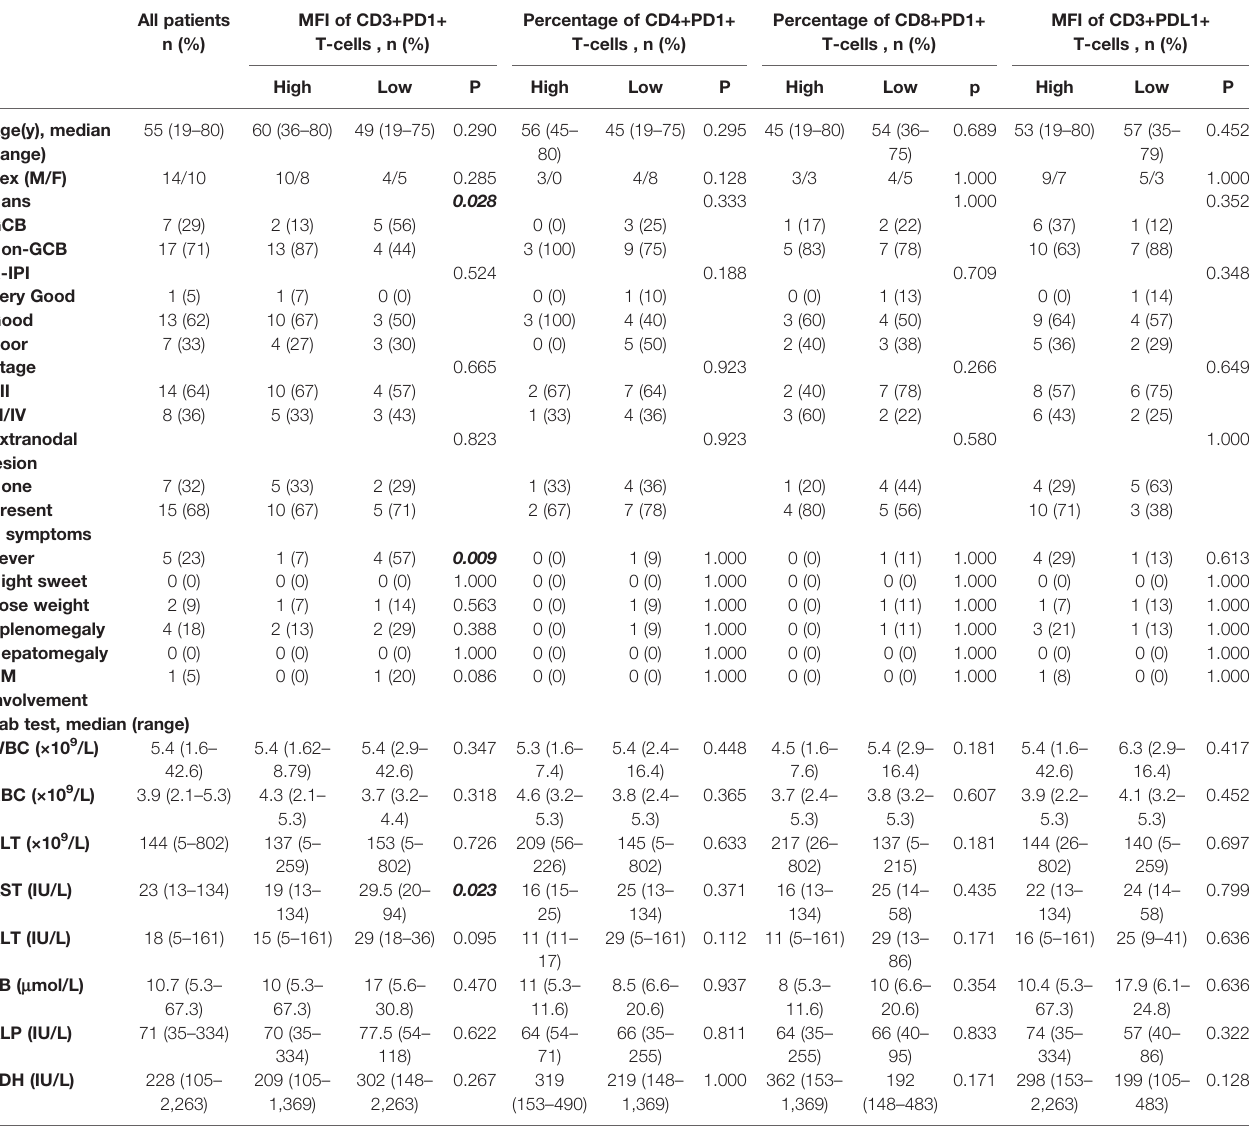
TABLE 1 | The baseline characteristics of patients with diffuse large B-cell lymphoma (DLBCL). All patients MFI of CD3+PD1+ n (%) T-cells , n (%)